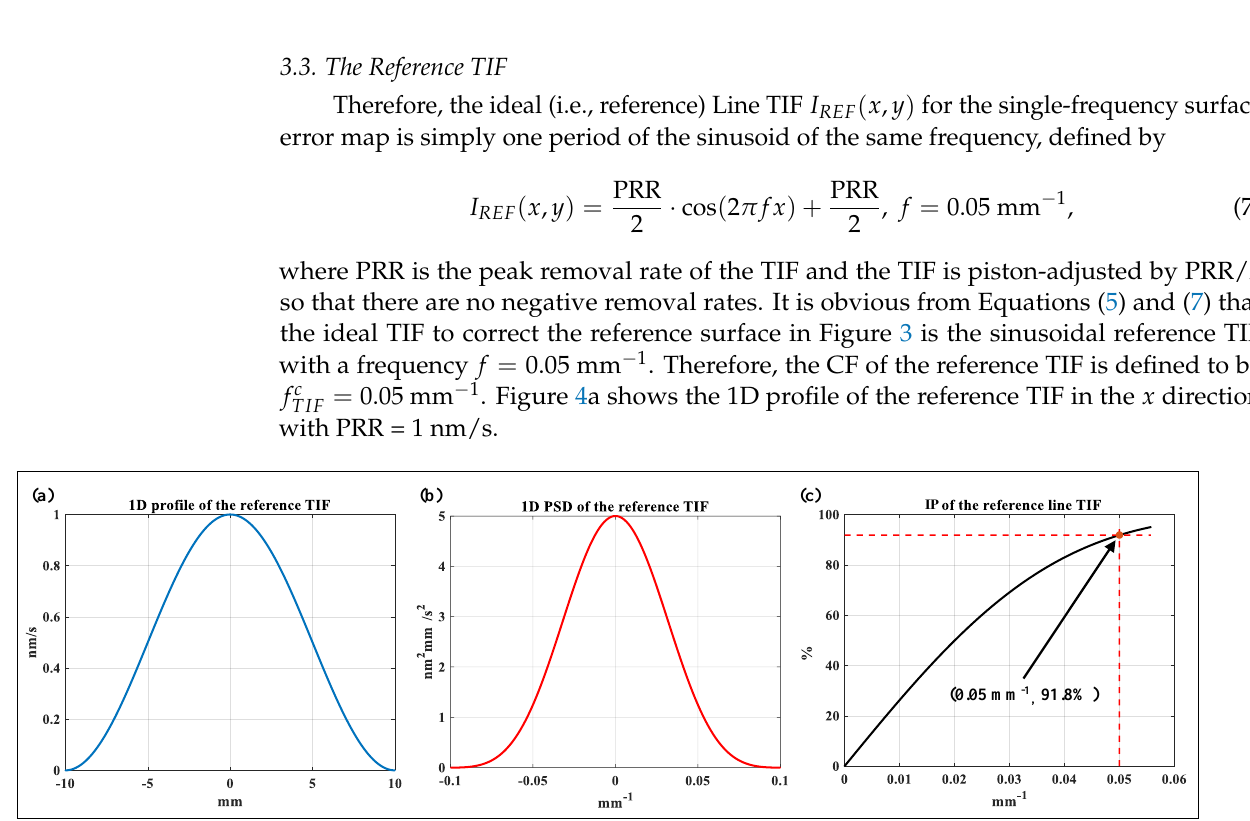
Figure 4. ( a ) Reference Line TIF with characteristic frequency f c reference Line TIF, and ( c ) IP of the reference